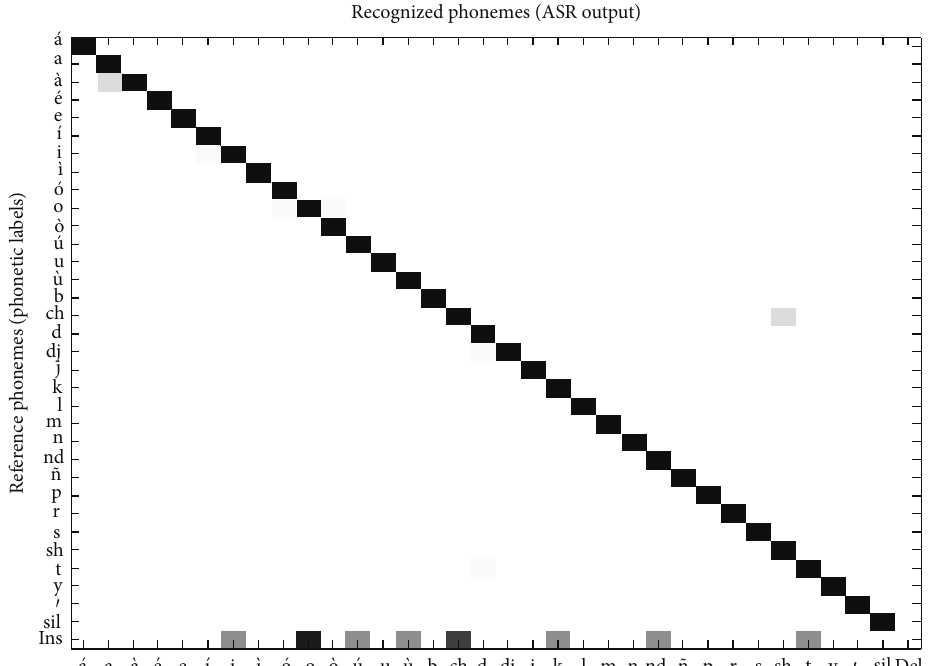
Figure 18: Phoneme confusion matrix of the baseline Mixtec ASR system on the training speech corpus.